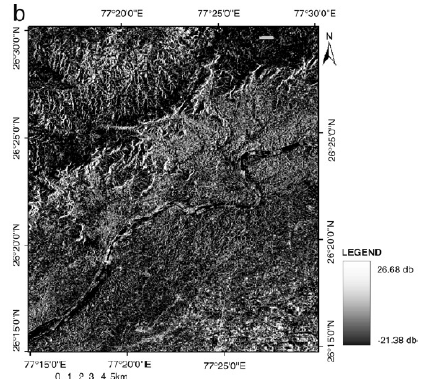
Fig. 2: Multi-look (5 x 1) backscattering ERS1 SAR data of the study area - after G filtering in order to suppress the micro te highlighting the meso and macro textures.